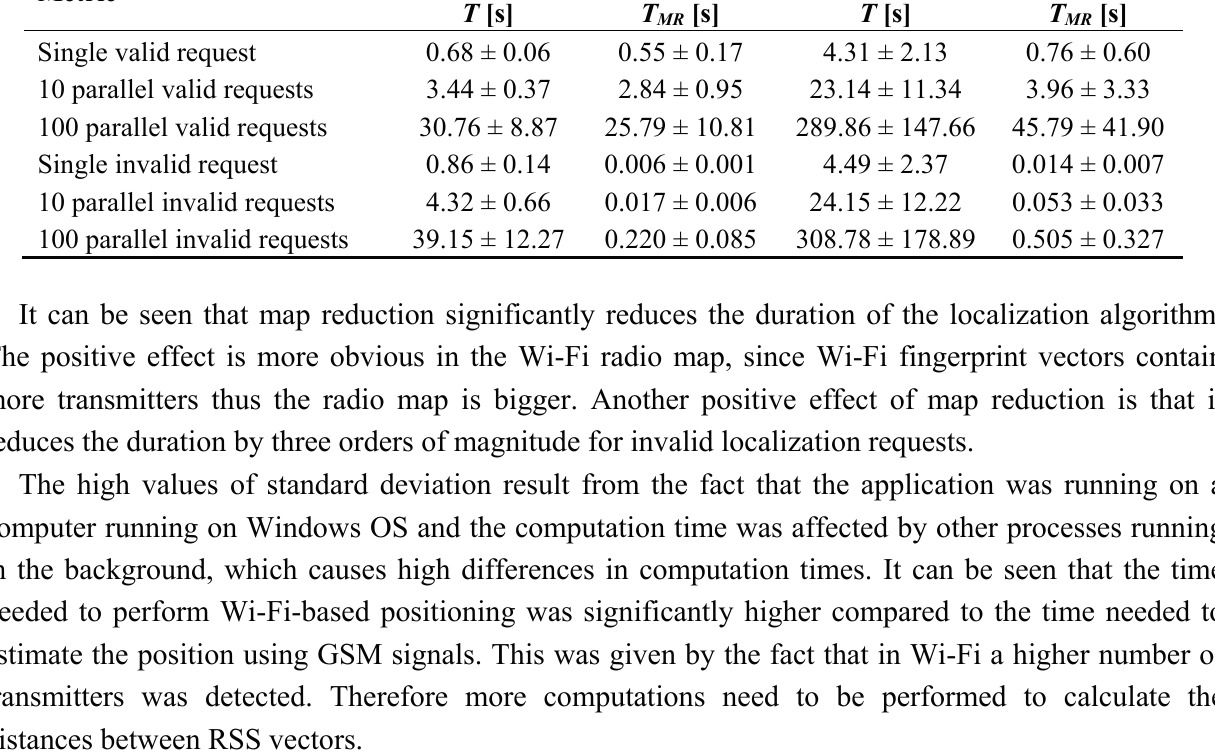
Table 5. Impact of proposed map reduction algorithm on the response time of localization server.